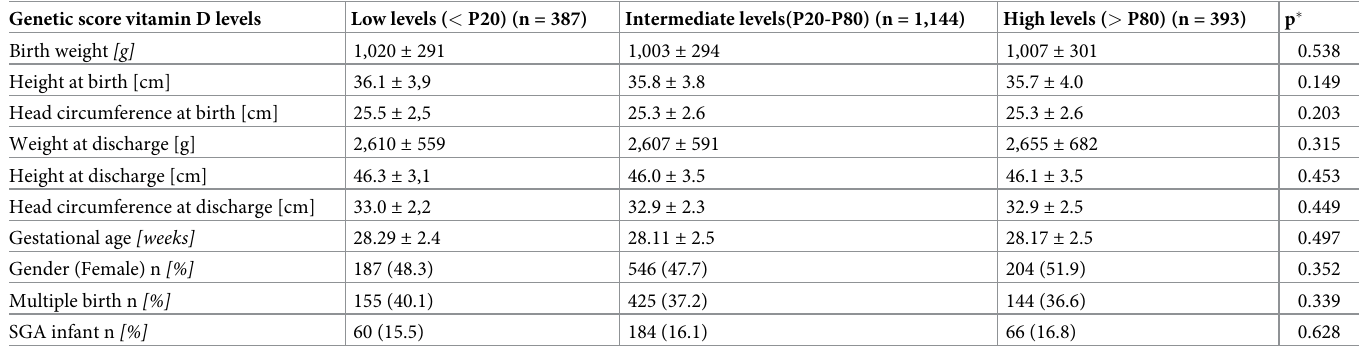
Table 1. Basic data of children with 5-year follow-up in relation genetic vitamin D level estimates. Genetic score vitamin D